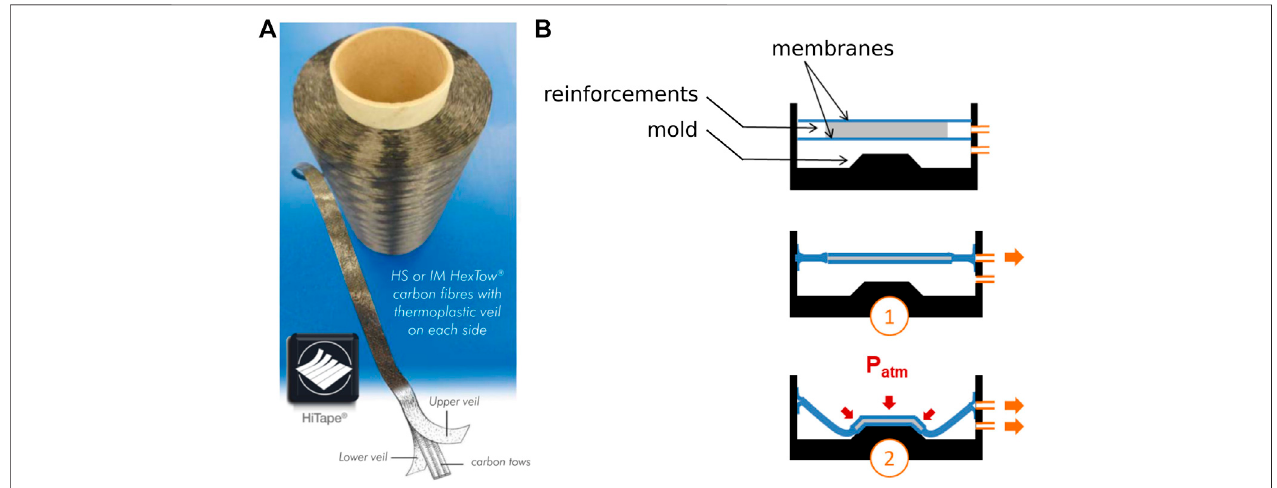
FIGURE 1 | Industrial context: (A) HiTape ® reinforcements for LCM processes (Hexcel, 2015b) and (B) schematics of double-membrane hot vacuum forming process, which consists in a compaction stage followed by a forming stage.